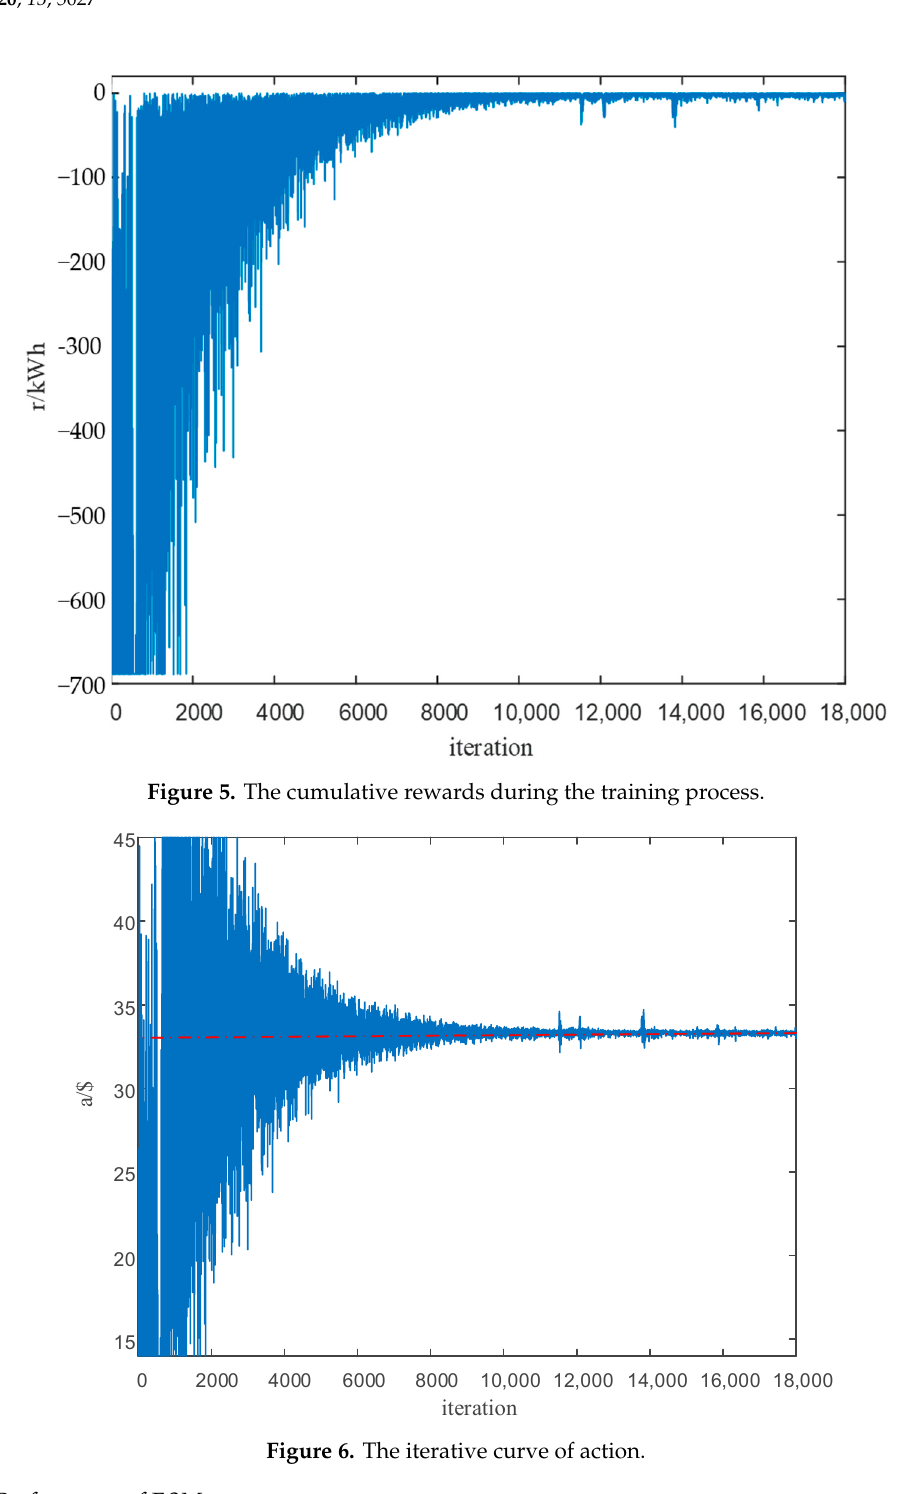
Figure 7. The ES price for different elasticity prosumers.